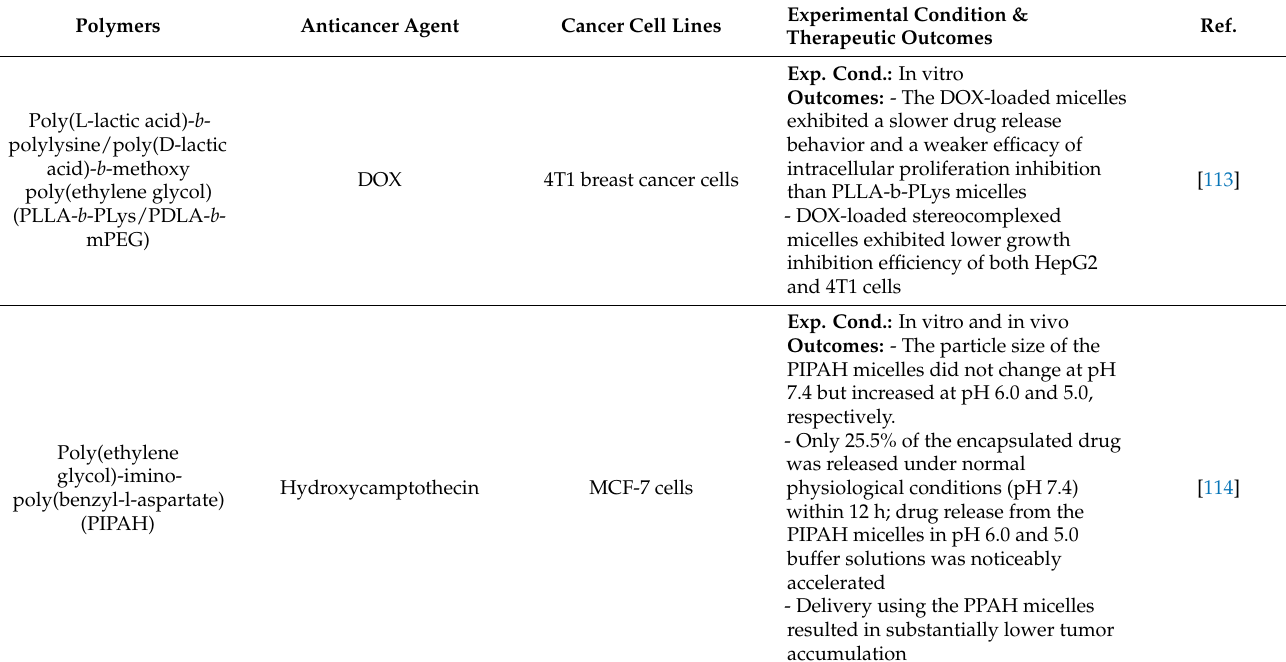
Table 3. Short summary of various pH-responsive polymeric micellar systems used for the treatment of